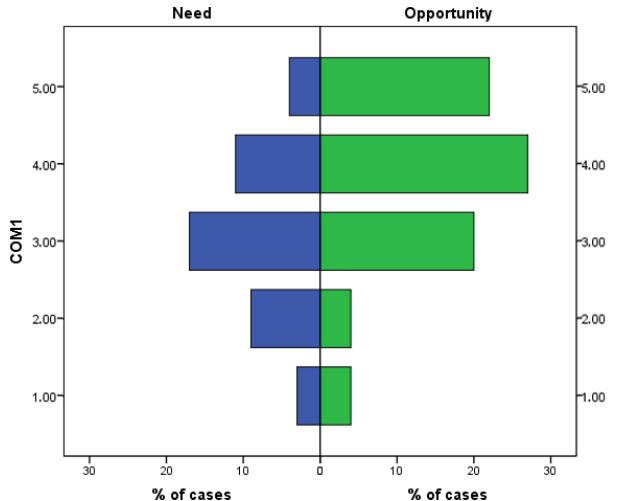
Figure 6. Barplot of COM1 (implementation of innovation) split per need and opportunity.